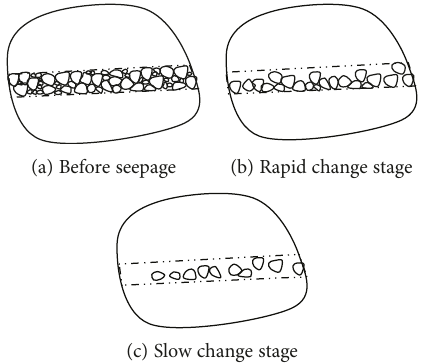
Figure 6: Schematic of migration and dissipation of fi ne particles in the test samples with gradations of n = 0 1 – 0.6.